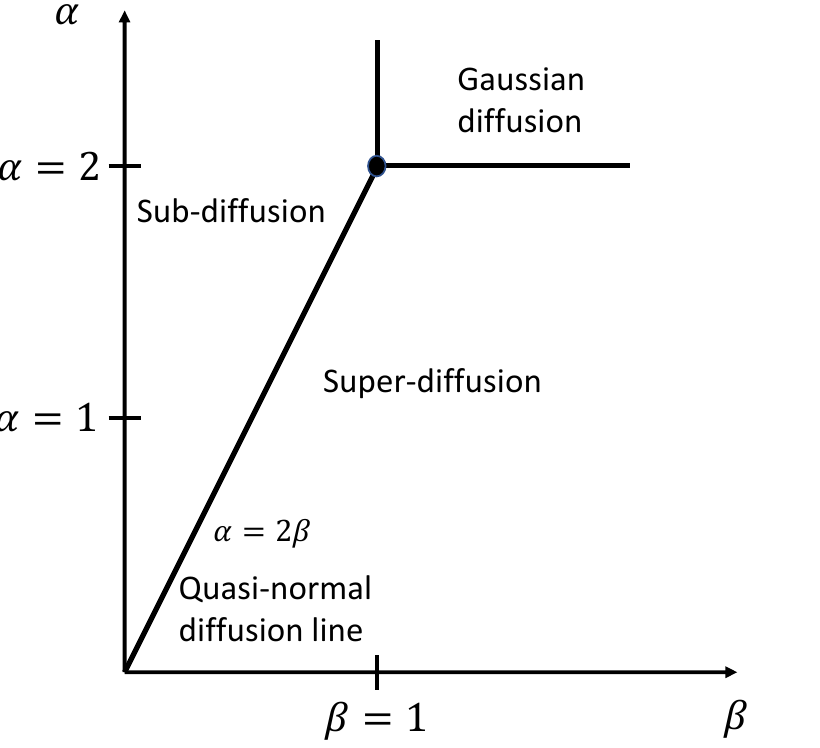
Figure 2. The phase diagram for the fractional diffusion equation in the domain β > 0, α > 0 is divided into four regimes, anomalous diffusion (0 < β < 1, 0 < α < 2), Gaussian diffu- sion, super-diffusion (Levy flight, 0 < α < 2, β = 1), and sub-diffusion (fractional diffusion, ( 0 < β < 1, α = 2). The line, α = 2 β , passes from the origin through the Gaussian (Brownian) diffusion point ( β = 1, α = 2 ) . In the region ( β > 1, α > 2 ) , the continuous time random walk model converges to Brownian motion in the limits as the Laplace and Fourier temporal and spatial frequen- cies approach zero s → 0, k → 0. In the region of anomalous diffusion, mean squared displacement (cid:10) (cid:11) = x 2 (MSD) is described by 2 D β , α t 2 β / α , where D β , α has the units m α / s β . When α = 2 β , the MSD exhibits quasi-Gaussian diffusion; that is, the MSD increases as a linear function of time, but the underlying diffusion process is not Brownian